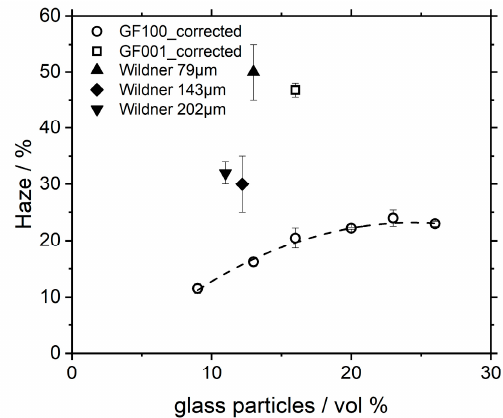
Figure 15. Haze of MGF in PVB compared to results from the literature of irregularly shaped glass particles in polymethyl methacrylate (PMMA) [9] with respect to volume content. Values were normalized to 500 µm sheet thickness.